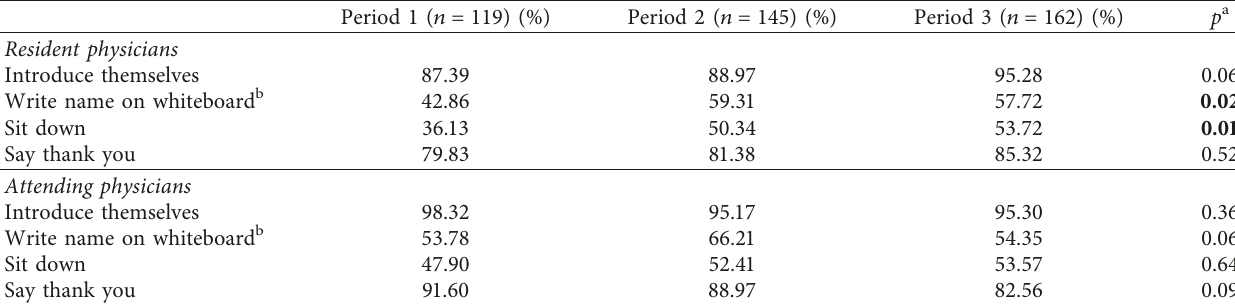
Table 1: Resident and attending physician interactions with patients.